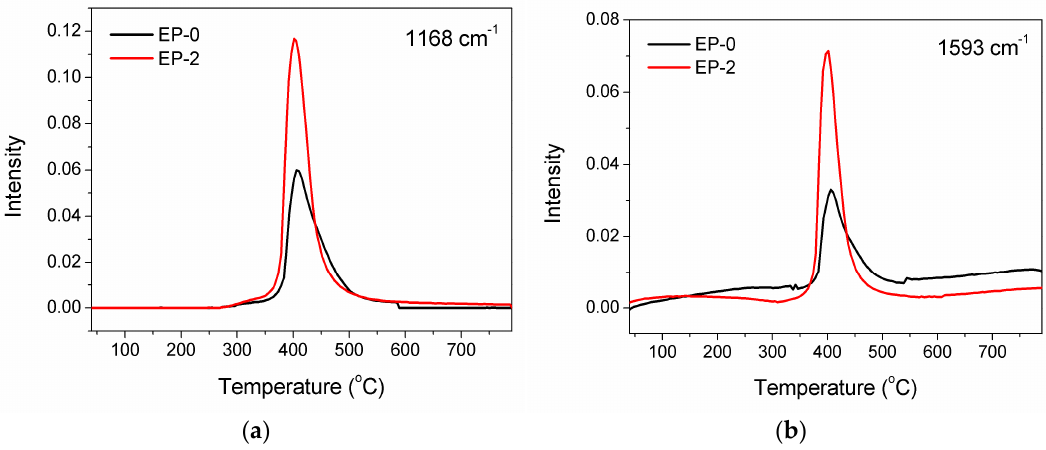
Figure 6. Absorbance intensities of ( a ) ether (1168 cm − 1 ) and ( b ) aromatic compounds (1593 cm − 1 ) emitted from decomposition of EP-0 and EP-2.